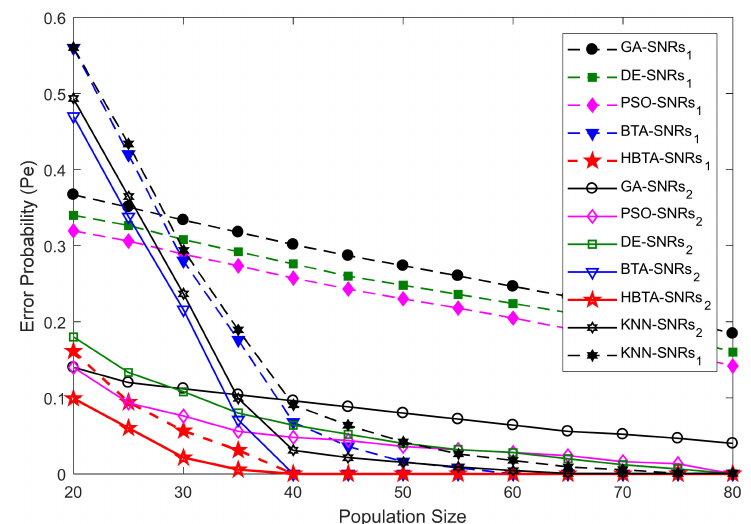
Figure 7. Error probability vs. population size in the presence of AY-AYC users with SNRs 1 ( − 9.5 dB) and SNRs 2 ( − 0.5 dB).